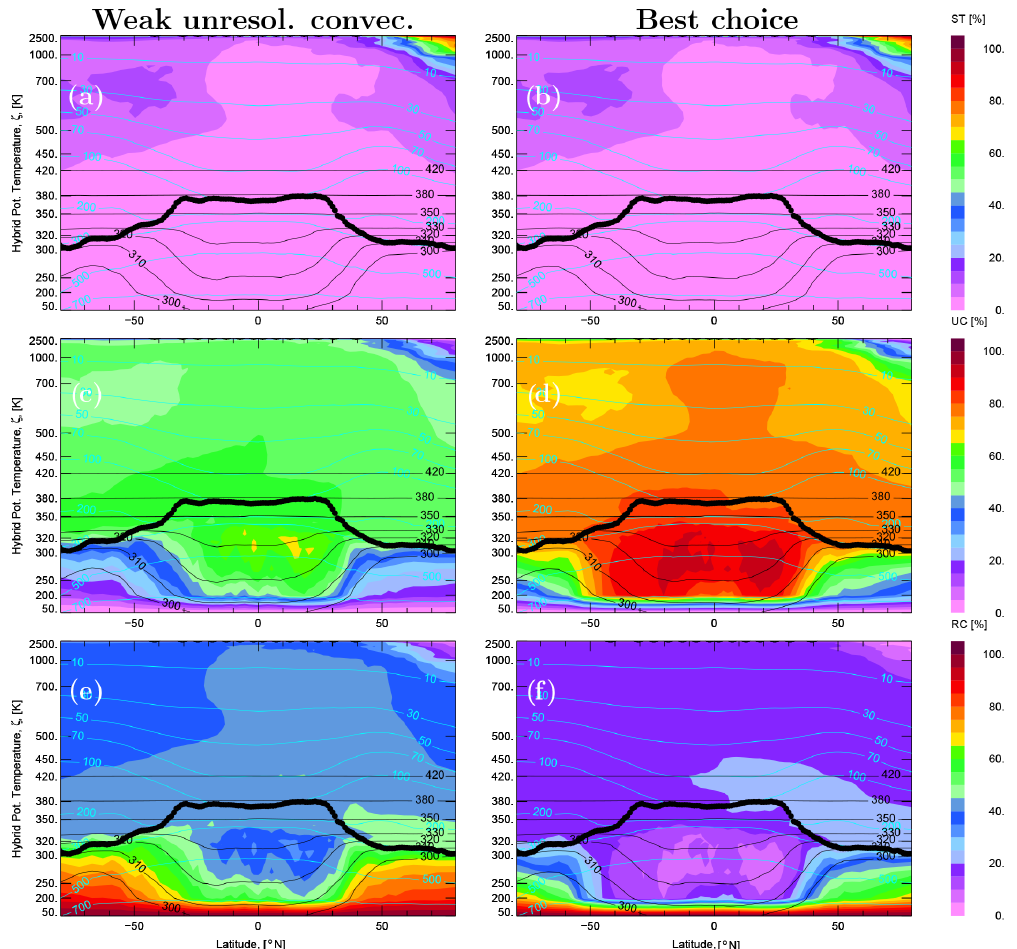
Figure 9. Budget of three origin tracers quantifying the contributions of the upper boundary (stratosphere (ST) panels a and b ) and of the lower boundary of CLaMS (unresolved convective updraft (UC) and transport resolved in ERA5 (RC) shown in panels (c) and (d) , and (e) and (f) , respectively). ST, UC, and RC are calculated for the last day of the 14yr perpetuum run (31 December 2017) for the weak contribution of the unresolved convection (left column, run I1C1(-1.0/30K) T0-E5) and for the best case (right column, run I1C1T0-E5). By repeating 14 times year 2017, a steady state with respect to these tracers was reached, i.e., ST + UC + RC = 100%. With lower boundary approximating the PBL, UC quantifies the contribution of unresolved convective updrafts and RC the contribution of the PBL following the transport resolved in the ERA5